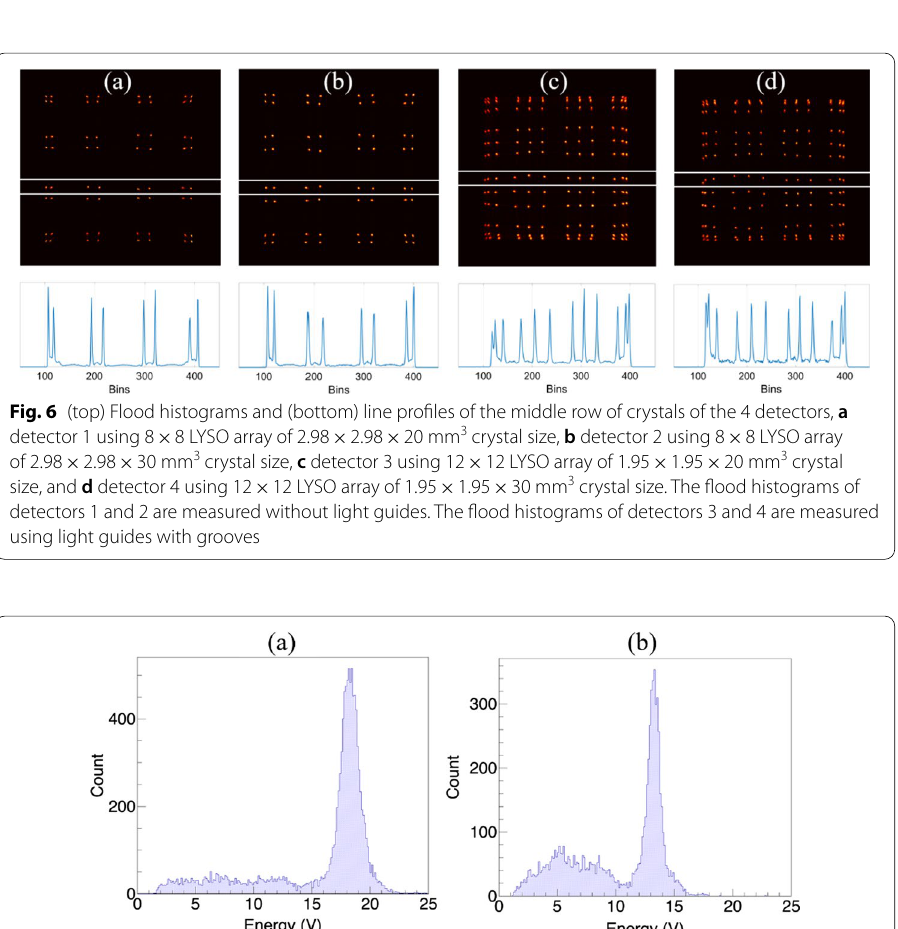
3 20 mm 3 crystal × ×